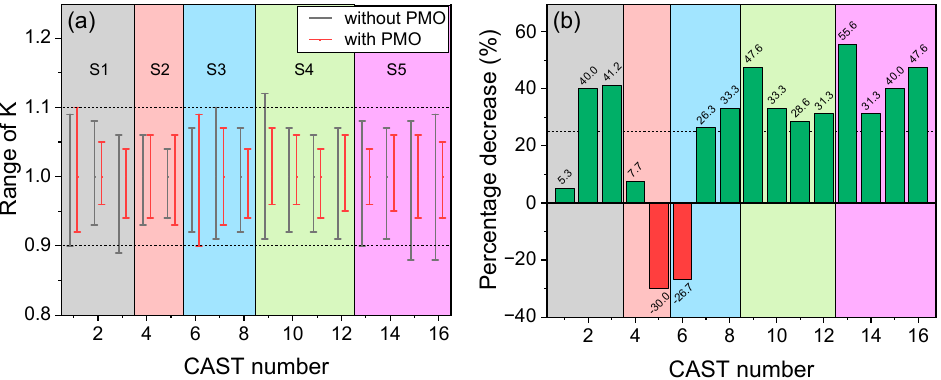
Figure 7. The K C range of the billet ( a ) and the percentage decrease ( b ) in the K C range of the billet with PMO to without PMO.